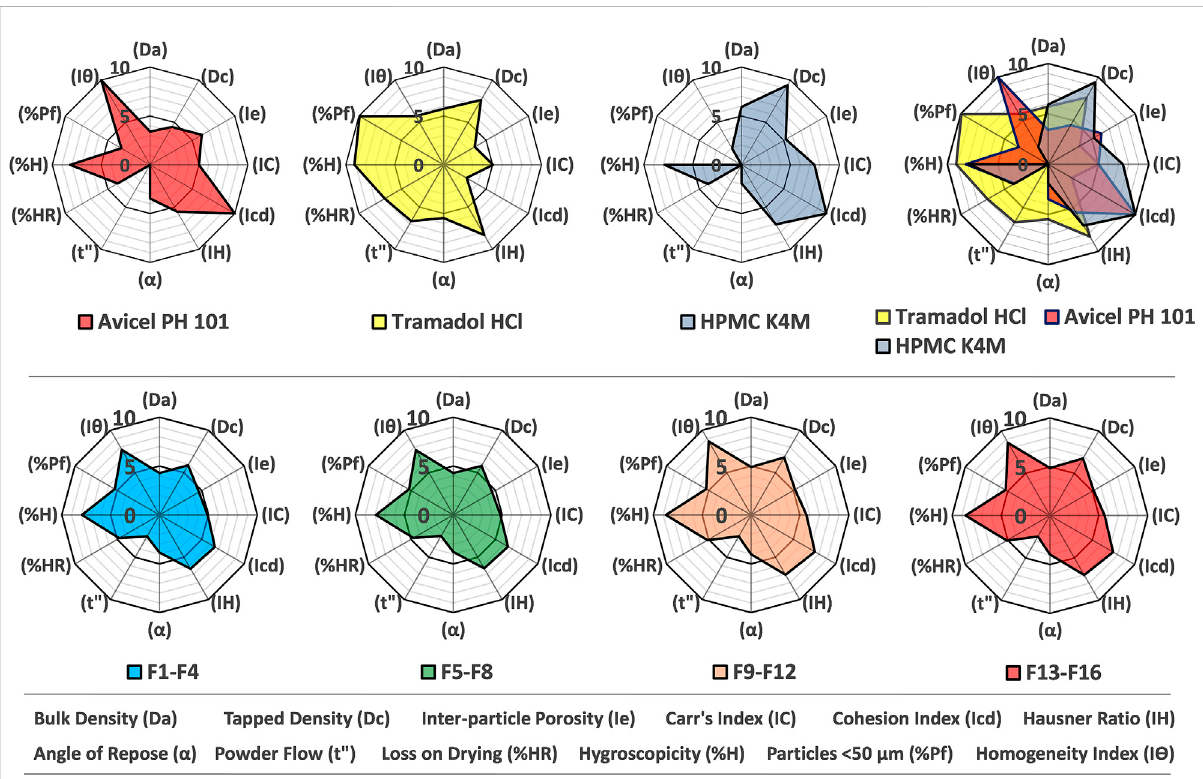
FIGURE 1 SeDeM diagram (radar plot) of Avicel PH101, tramadol HCl, Methocel ™ K4M, overlay plot (upper segment) and formulations from F1-F4, F5-F8, F9-F12 and F13-F16 (lower